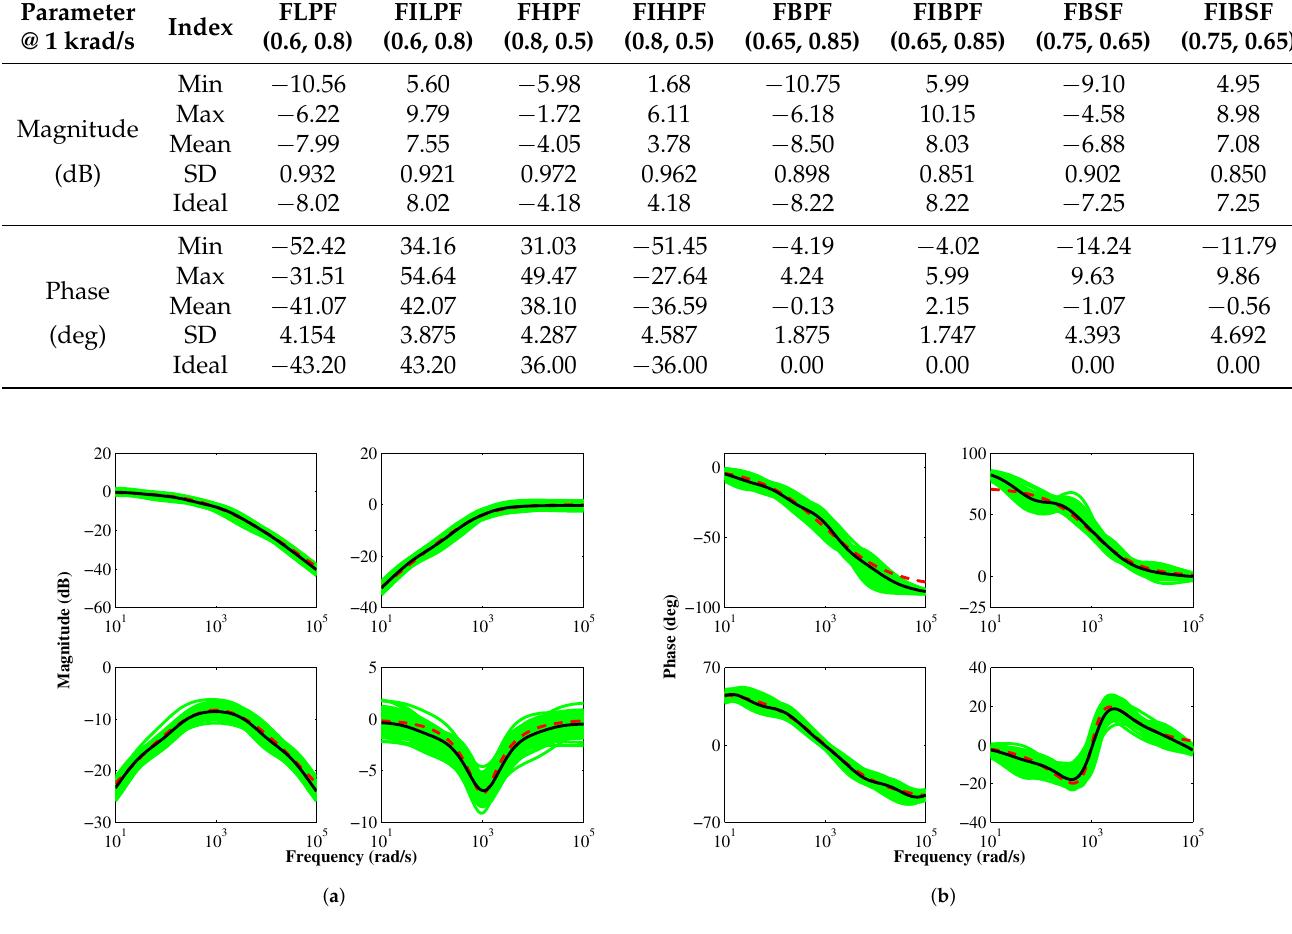
Figure 10. SPICE simulated ( a ) magnitude and ( b ) phase responses of the proposed FLPF, FHPF, FBPF, and FBSF. [Note: Theoretical responses are shown in dashed red; responses based on nominal values of components are shown in solid black; Monte-Carlo simulation-based responses are shown in